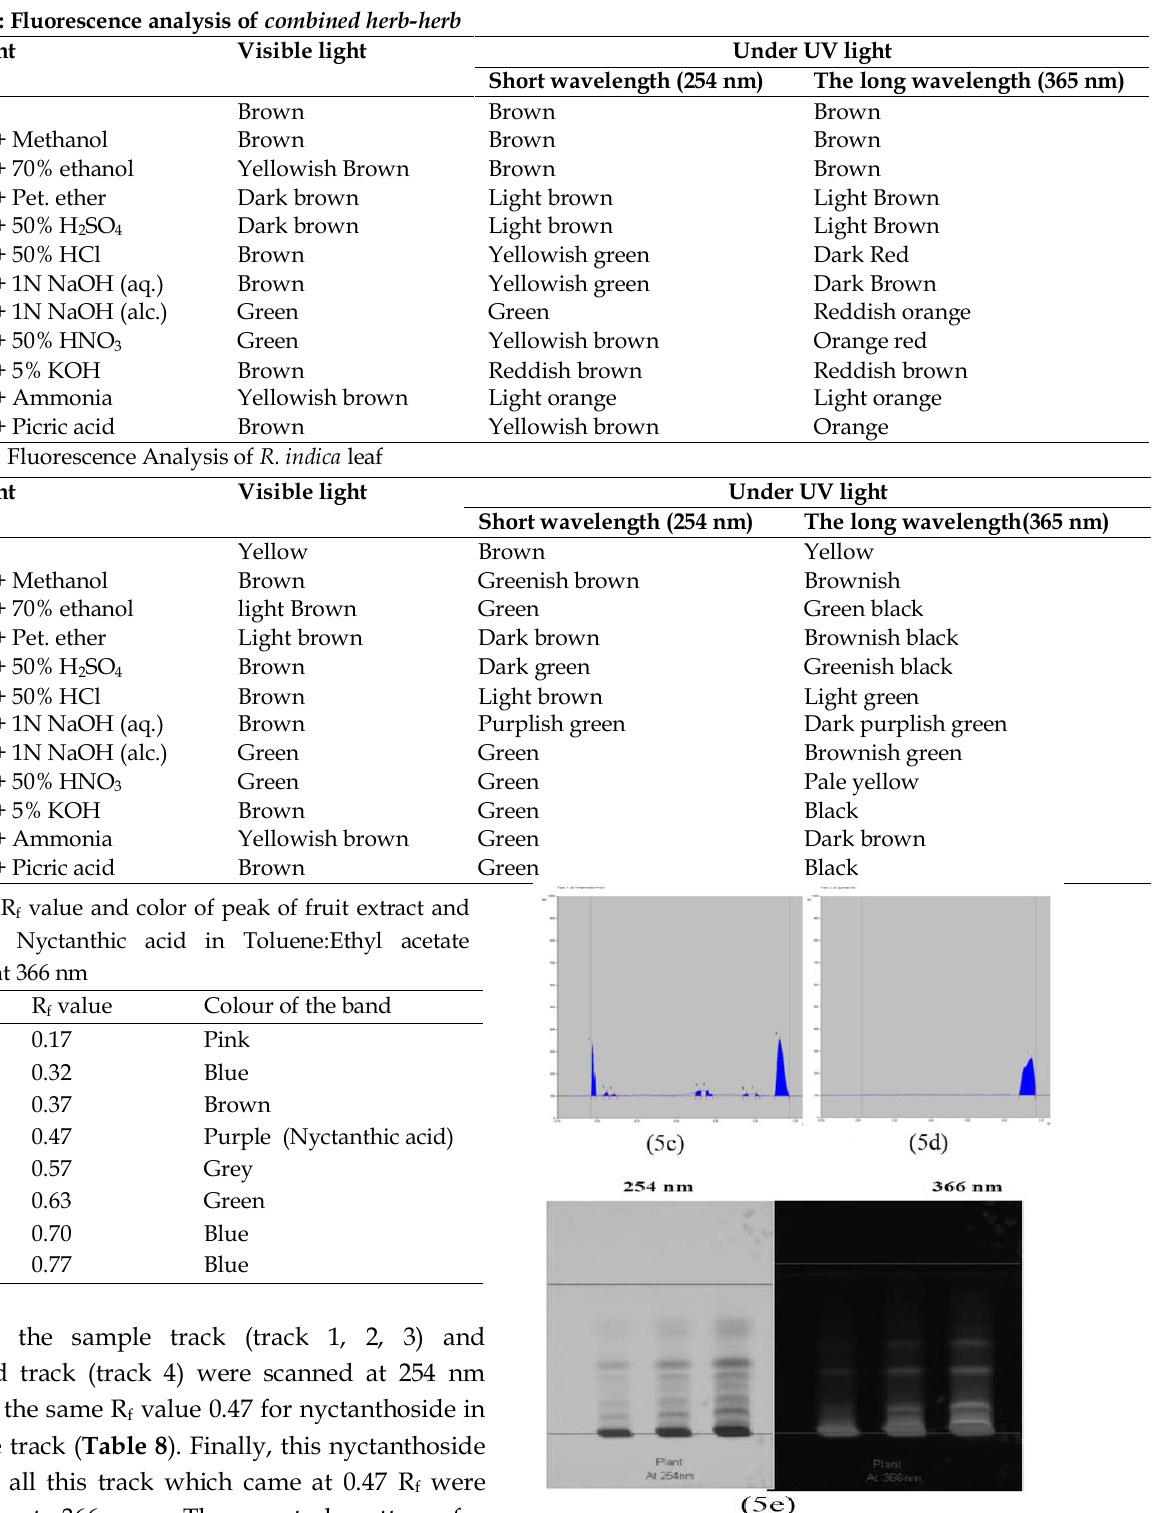
Figure 5c , 5d & 5e : HPTLC profile of hydroalcoholic of H. salicifolia with standard Quercetin as developed in Ethylacetate: Dichloromethane: Formic acid: Acetic acid: Water (10:2.5:1:1:0.5). Figure 5c represents fruit extract of H. salicifolia and Figure 5d represents Quercetin standard. Figure 5e represents photo documentation report of hydro-alcoholic extract of H. salicifolia at 254 nm and at 366 nm. FE=fruit extract; ST=Standard.